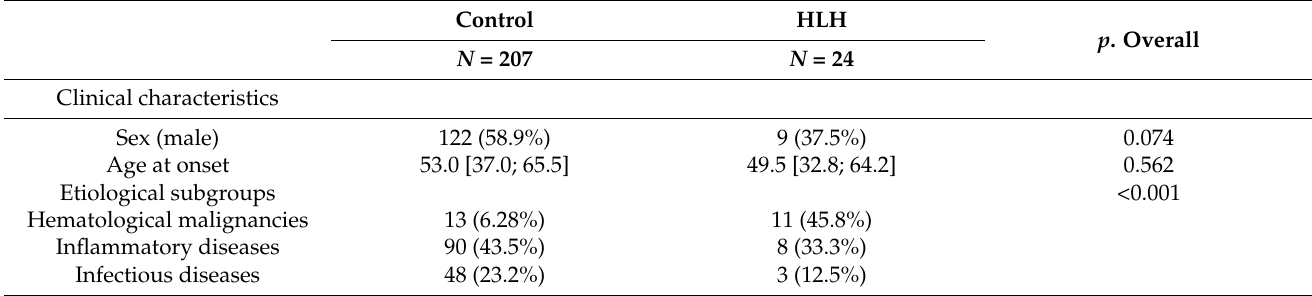
Table 1. Summary description of the original